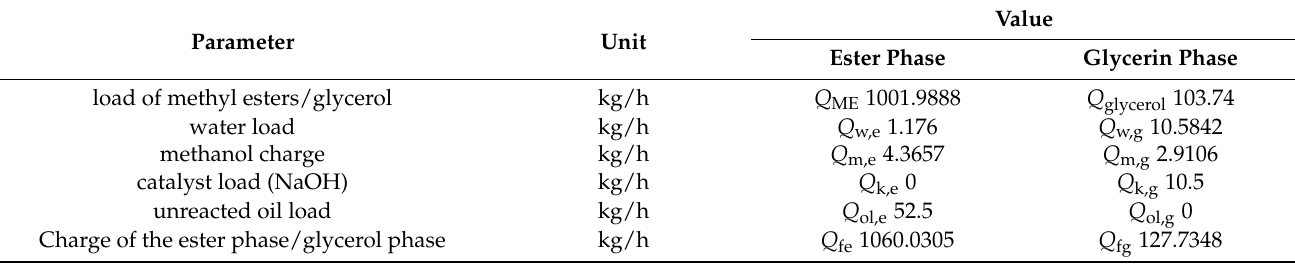
Table 4. Ester and glycerol fractions discharged from the separator.